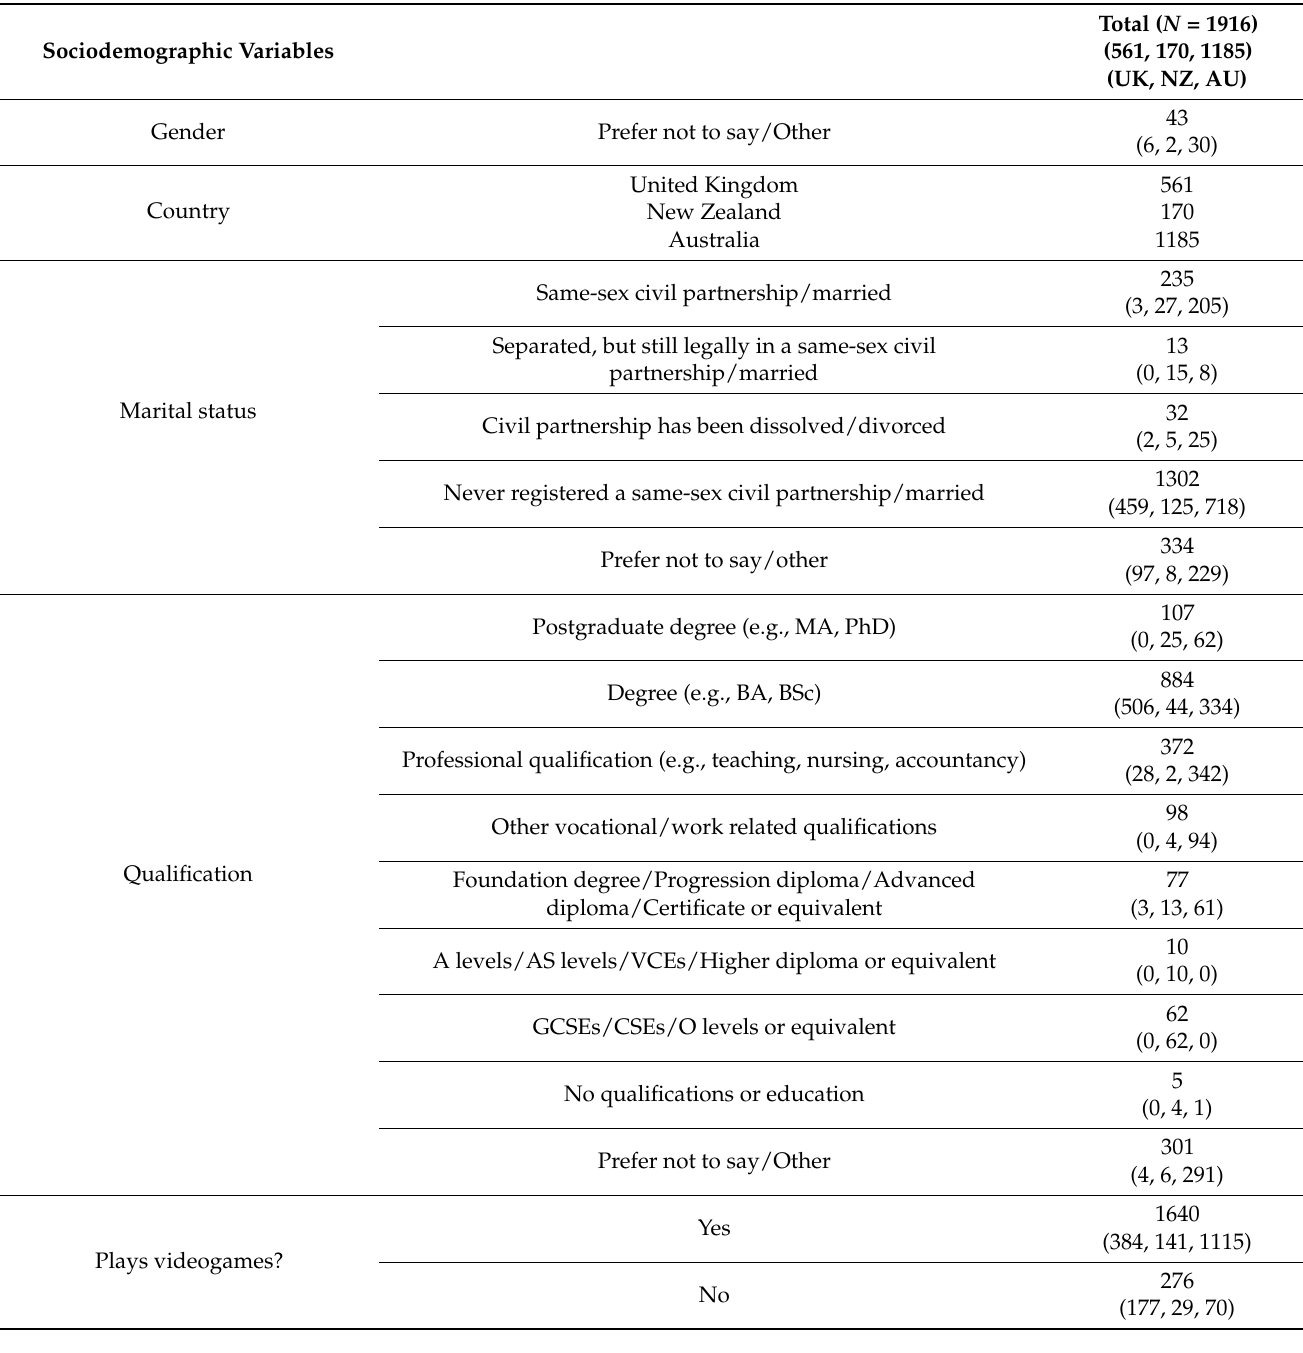
Table 1. Demographics and videogame use